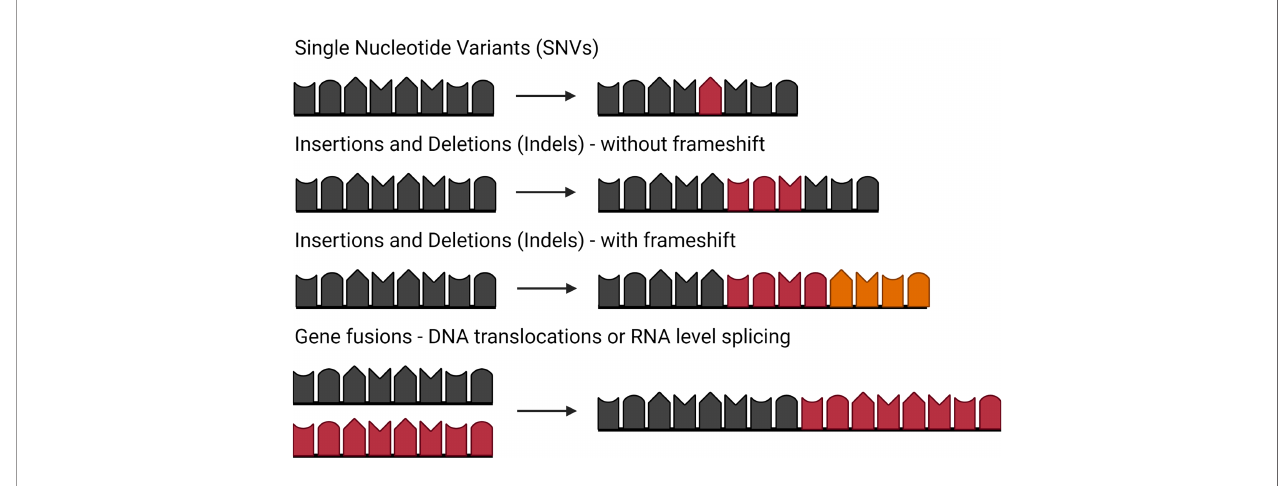
FIGURE 3 | Types of mutations that can lead to neoantigens. Single nucleotide variants (SNVs) caused by a point mutation in a single nucleic acid. Insertions and deletions (indels) caused by addition of nucleic acids or loss of nucleic acids. Indels with a frameshift occur when the number of nucleic acids is not a multiple of three, changing the reading frame. Gene fusions can be caused by either translocations at the DNA level or RNA splicing of independent transcripts. Figure created with